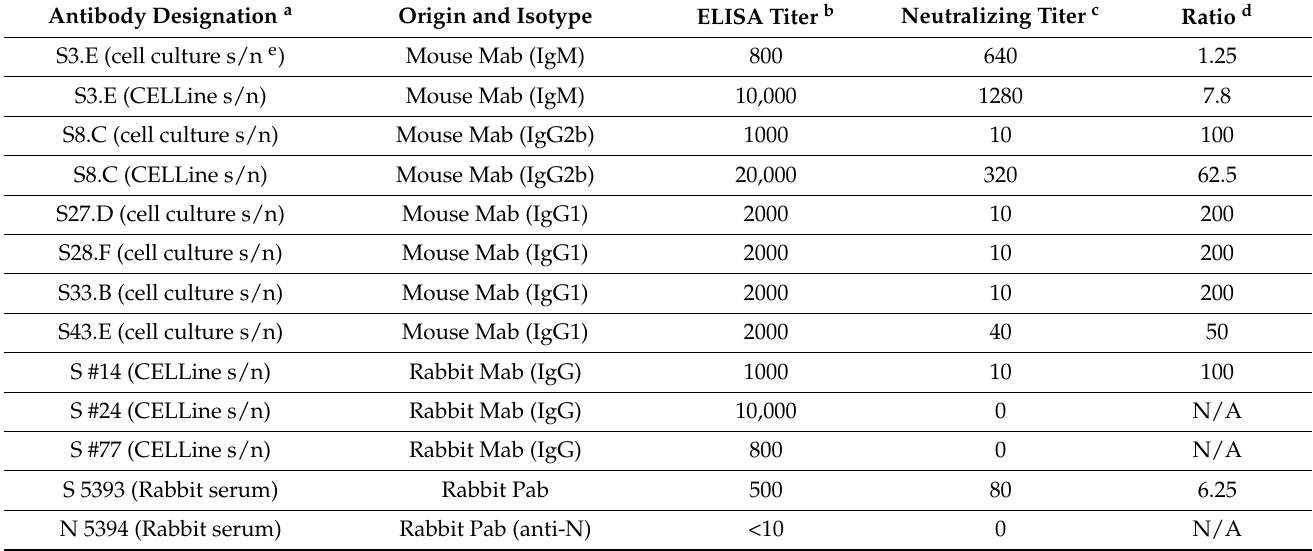
Table 2. Neutralizing activity of mAbs and pAbs.